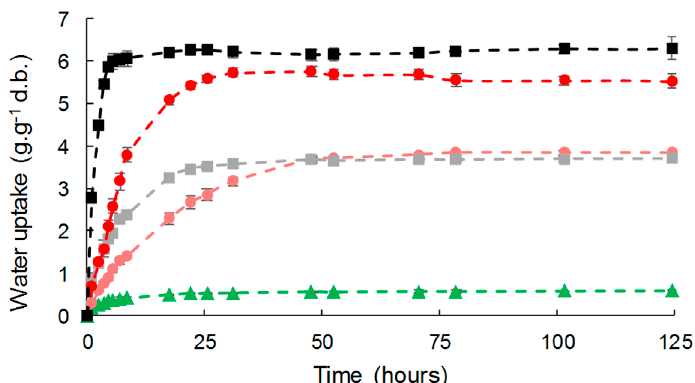
Figure 7. Water liquid sorption kinetics for PHBV-based composites: PHBV ( ▲ ), PHBV-20VC ( ■ ), PHBV-20GC ( ● ), PHBV-33VC ( ■ ), PHBV-33GC ( ● ). Points were linked for more visibility.